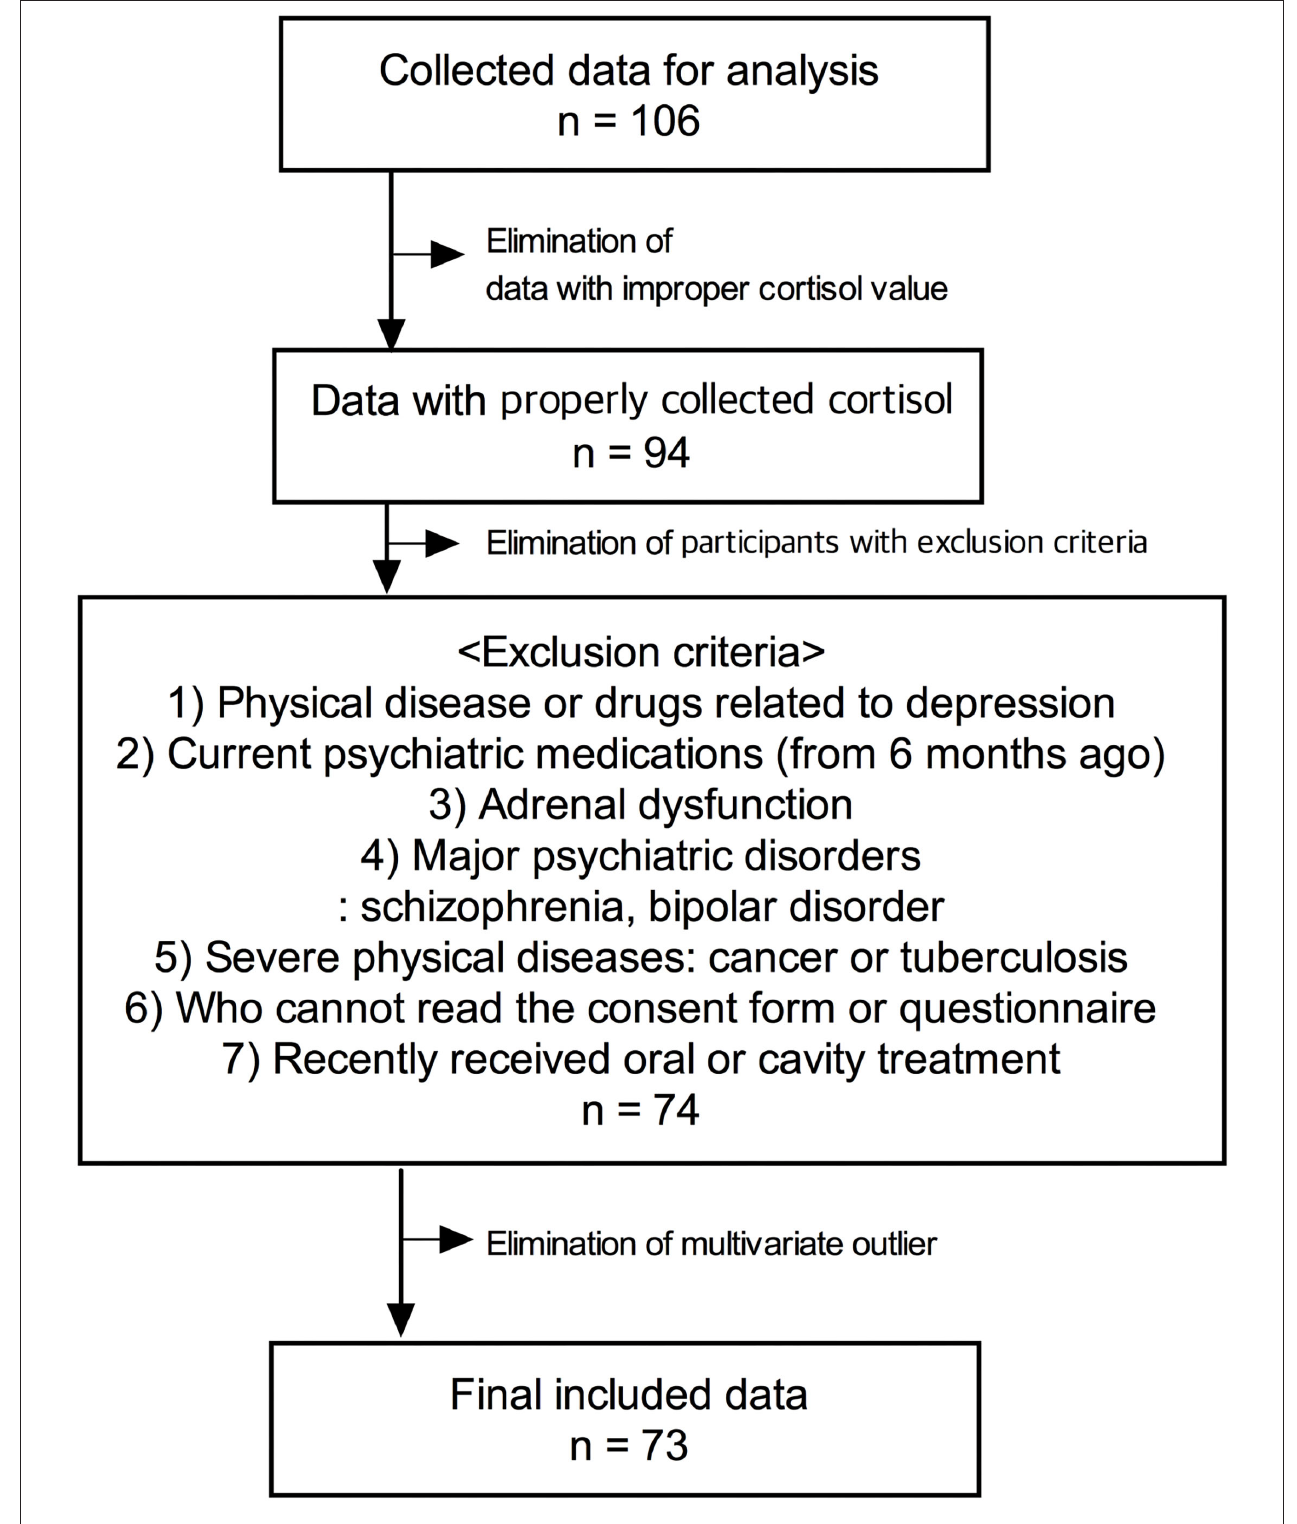
FIGURE 1 | Flow chart summary of the participation exclusion process for analysis.